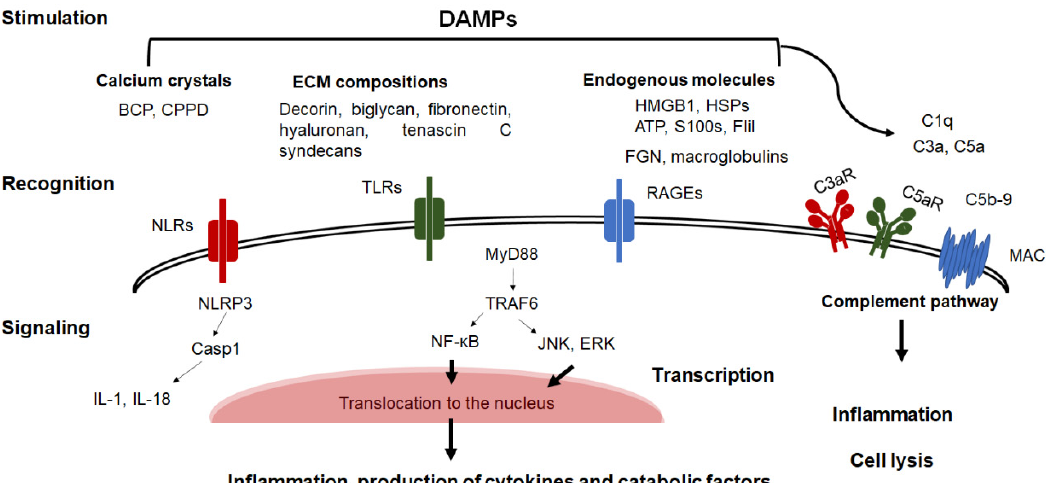
Figure 2. Schematic representation of the role of DAMPs in the initiation of LGI. DAMPs, including cartilage compositions, crystals, endogenous molecules, and plasma proteins, are recognized by PPRs, including NLRs, TLRs, and RAGEs resulting in the activation of several signaling pathways involved in the production of proinflammatory cytokines and proteolytic enzymes by macrophages and chondrocytes. The binding of DAMPs to complement molecules activate the complement pathway resulting in cell activation leading to inflammatory responses and cell lysis.